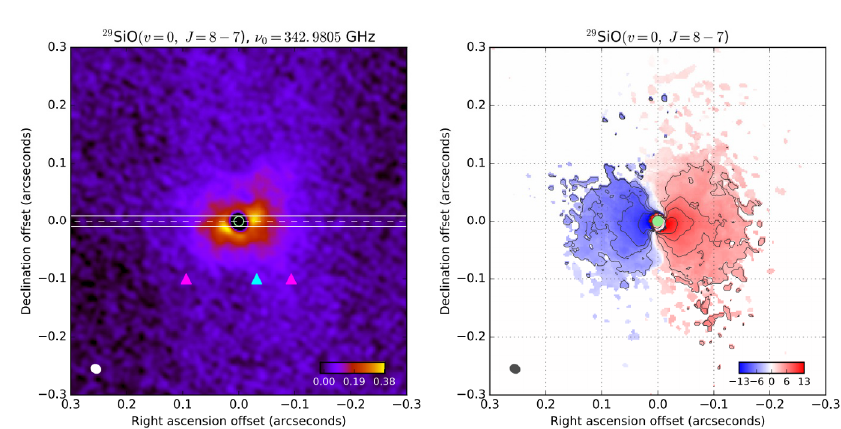
Figure 5: Left panel: map of the emission from L 2 Pup in the 29 SiO( v =0, J=8 − 7) line. The solid white lines present the slit of 20 mas used to compute the position-velocity diagrams. Right panel: Doppler velocity map (the colour scale is in km s − 1 ).